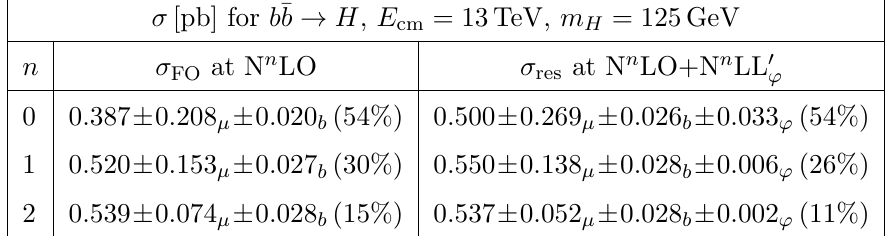
Table 3 . Total b (cid:22) b ! H cross section at m H = 125 GeV at the LHC with E cm = 13 TeV. The central scales are (cid:22) FO = m H , (cid:20) F = 1 = 4. The percent uncertainties correspond to the quadratic sum of all